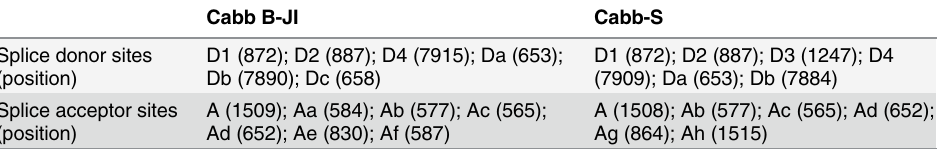
Table 1. Splice donor and acceptor sites found in Cabb B-JI and Cabb-S strains by RT-PCR. 85 and 44 clones from two independent experiments were sequenced for Cabb B-JI and Cabb-S strains, respectively. Sites Da to Dc and Aa to Af were named according to their order of discovery in Cabb B-JI